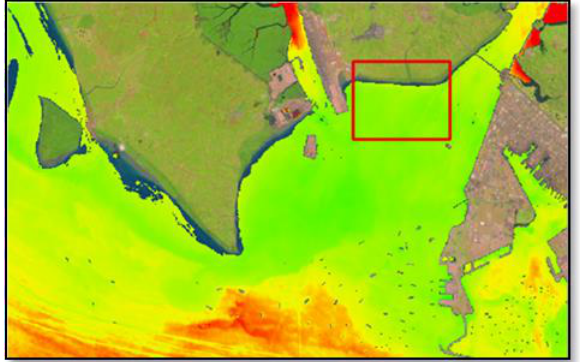
Figure 10. Overview imagery-derived bathymetric model from Dierssen et al’s band ratio